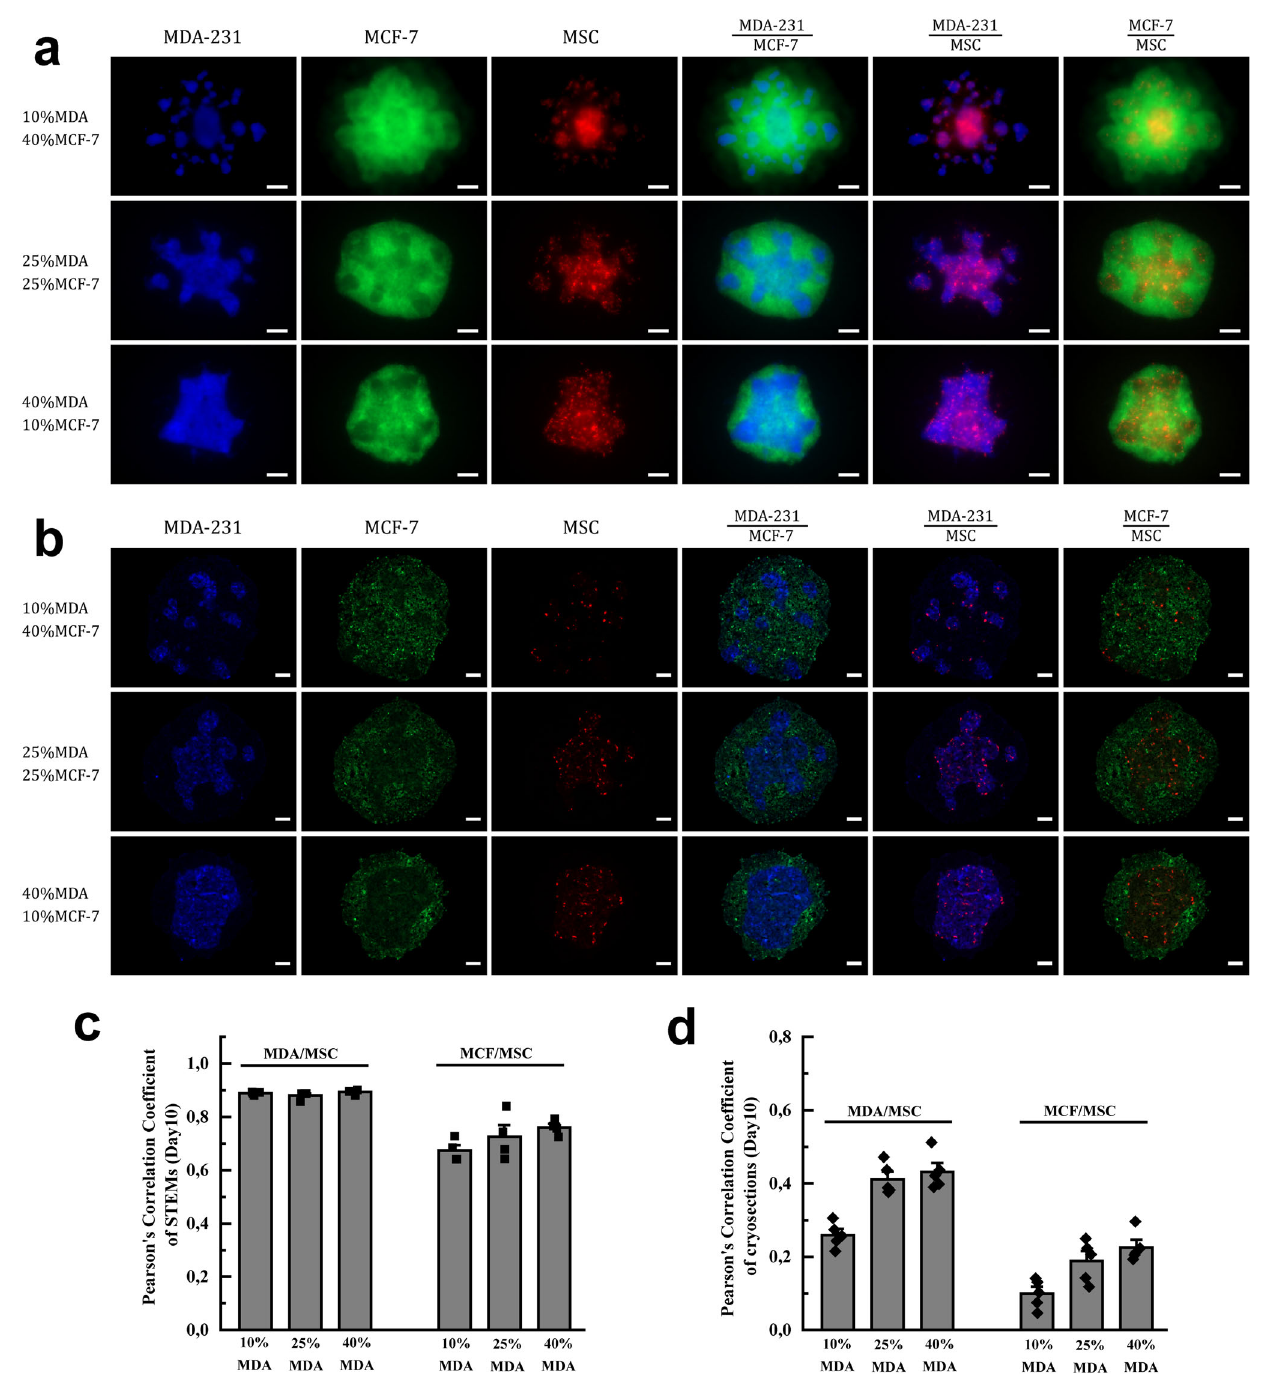
Fig. 2 MDA promotes redistribution of MSC in MCF STEMs. a Fluorescence microscopy images of MCF STEMs bearing increasing fractions of metastatic cells (MDA-231/BFP, MCF-7/GFP, MSC/tdTomato, and EC (unlabeled), scale bar: 200 µ m. The introduction of MDA drives the redistribution of MSC throughout the structure, providing evidence for associative tendencies between MSC-MDA. b Fluorescence microscopy images of cryosections of MCF- STEMs containing a different cellular fraction of MDA cells, scale bar: 100 µ m. c PCCs of MDA/MSC and MCF/MSC in MCF-STEMs containing increasing fractions of MDA, n = 4. d PCCs of MDA/MSC and MCF/MSC in cryosections of MCF-STEMs containing increasing fractions of MDA, n =